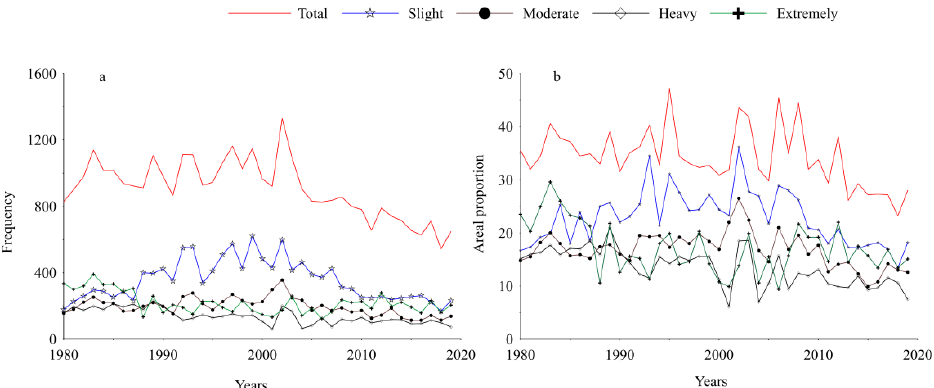
Figure 1. Variation of the frequency ( a ) and areal proportion of snow disasters ( b ) on the QTP over past 40 years.